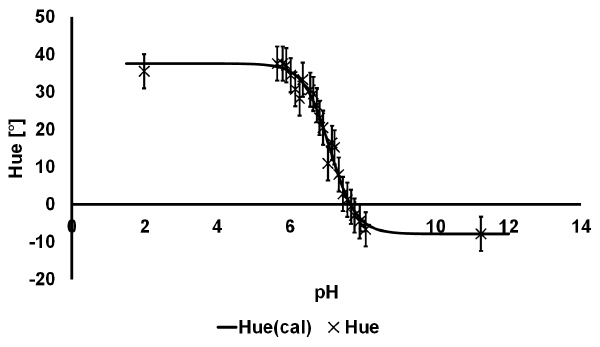
Figure 7. Hue data (mean value of 10 measurements) depending on pH values measured in a single chamber. PhR diluted in a ratio of 1:5 in SPPB. The fitting parameters are the following: pK a = 7 . 43, α = 1 . 04 and 2 σ = 1 . 21 ◦